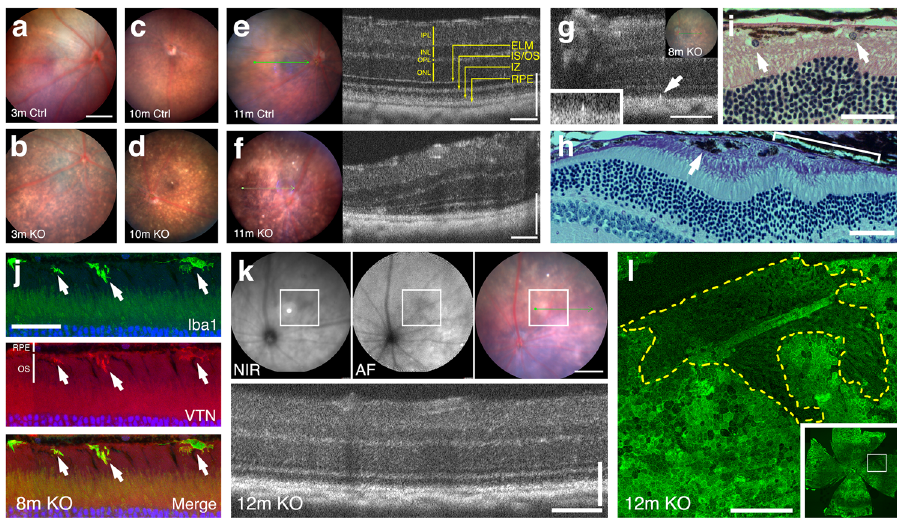
Fig. 2 RPE Δ Clic4 mice progressively develop histopathological features resembling intermediate and advanced AMD. a – g Fundus and OCT images of Ctrl ( a , c , e ) and KO ( b , d , f , g ) mice of indicated ages in months (m) are shown. IPL inner plexiform layer, INL inner nuclear layer, OPL outer plexiform layer, ONL outer nuclear layer, ELM external limiting membrane, IS/OS inner segment/outer segment, IZ interdigit zone of RPE/outer segment. g Highlights the wedge-shaped hyperre fl ectivity extending from the RPE toward the outer segment region (arrow, inset). h , i H&E ( i ) and Toluidine blue ( h ) stained retinal sections >12-month-old KO mice reveal the subretinal expression of pigmented ( h ) and non-pigmented ( i ) cells, as well as the RPE-free zone (bracket). j Confocal images show the overlapped Iba1 and vitronectin (VTN) staining distributed between RPE and outer segments (arrows) in a 6-8- month-old KO mouse. k , l shows the near-infrared (NIR), auto fl uorescence (AF), color fundus and OCT images (in k ) as well as the F-actin stained wholemount ( l ) of the same KO mouse eye. l The en face view of the region corresponding to the reduced auto fl uorescence (boxed in k and l inset). The enlarged image of this region reveals an RPE-free zone (dashed line) from which the underlying choroidal vessels are visible. Nearby dark patches (due to the RPE cell loss) are also discernable. Representative images of more than three independent experiments (of a – g ; also see Supplementary Table 1) and three independent experiments (of h , i ) are shown. Bars = 400 (fundus photographs in a – f , k ), 100 (OCT images in e , f , g , k ), 50 ( h ), 40 ( I , j ), and 200 ( l ) μ